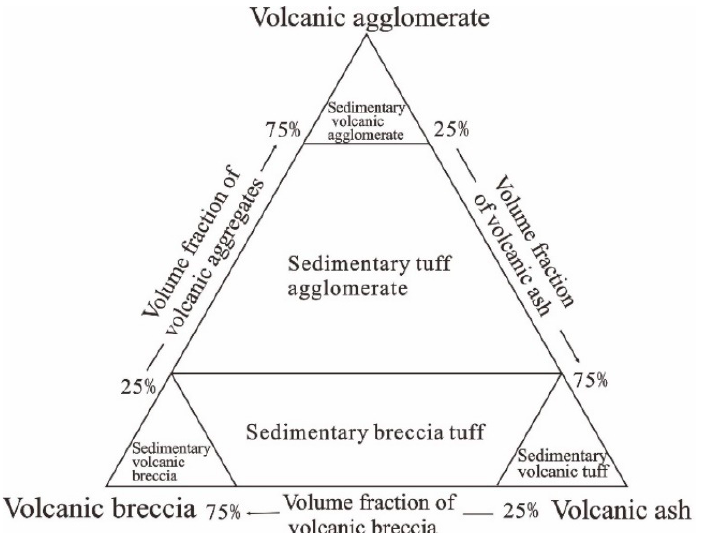
Figure 2. Grain-size diagram for naming sedimentary pyroclastic rocks (Modified from Fisher; Wang et al.; Zhou et al. [20–22]). The pyroclastic particle size above 64 mm is volcanic agglomerate. From 2 mm to 64 mm is volcanic breccia, and less than 2 mm is volcanic ash.